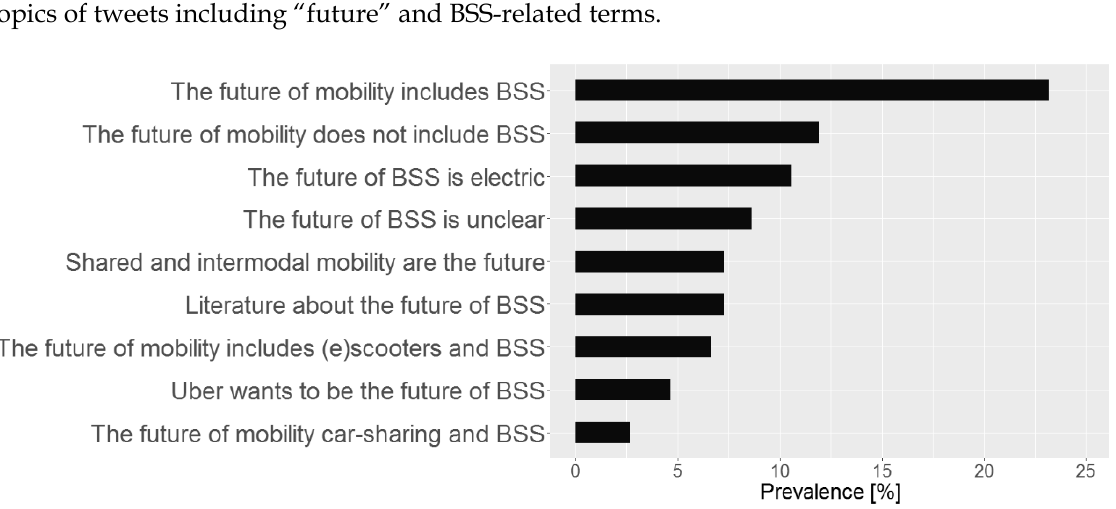
Figure 10. Topic clustering considering the BSS-related tweets classified as negative (n=142) Around 50% of the tweets stated that BSS are included in the future of mobility. Highlights are towards the future of BSS being electric and the future of mobility including other shared modes e.g. scooters and cars. On the other hand, 11.9% of the tweets stated that BSS is probably going to collapse. It is worth mentioning, that around 50% of these statements specifically refer to Asian dockless BSS